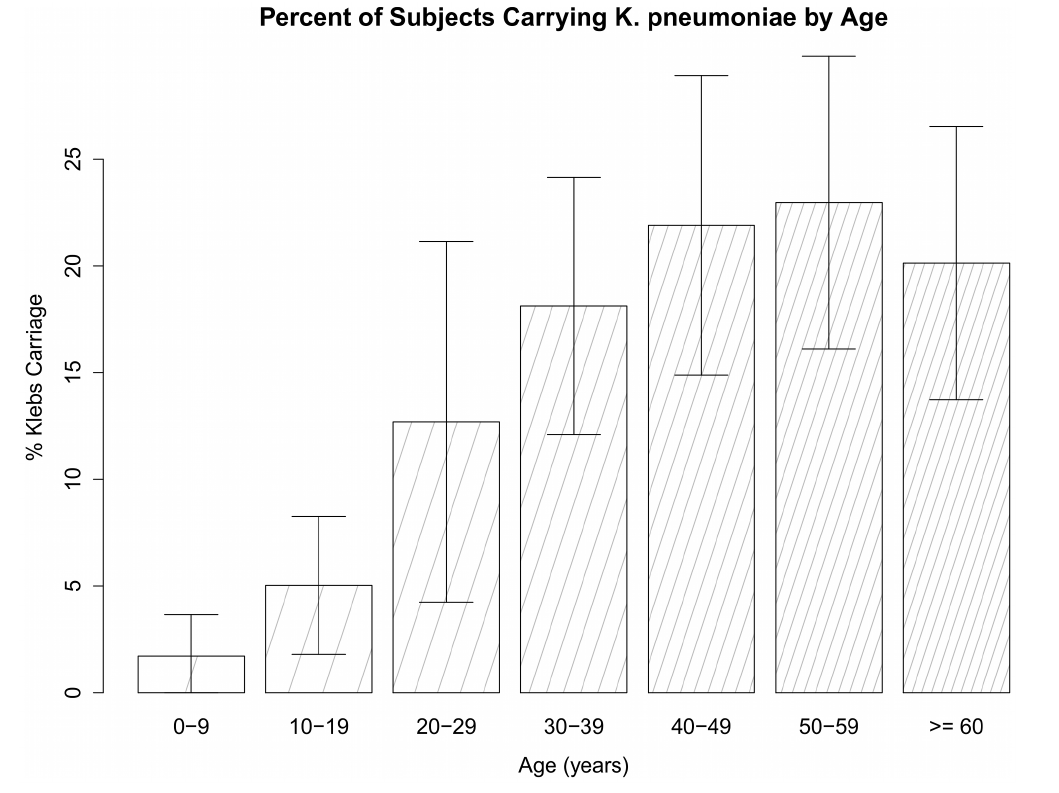
Figure 1. Prevalence of nasopharyngeal carriage of K.pneumoniae by age group – main cohort. Subjects are from Dong Da (urban) and Ba Vi (rural), two locations in Northern Viet Nam near Ha Noi. Age was found to be a significantly positively associated with K. pneumoniae carriage. Although age categories are used for this figure, age was analyzed as a continuous variable.